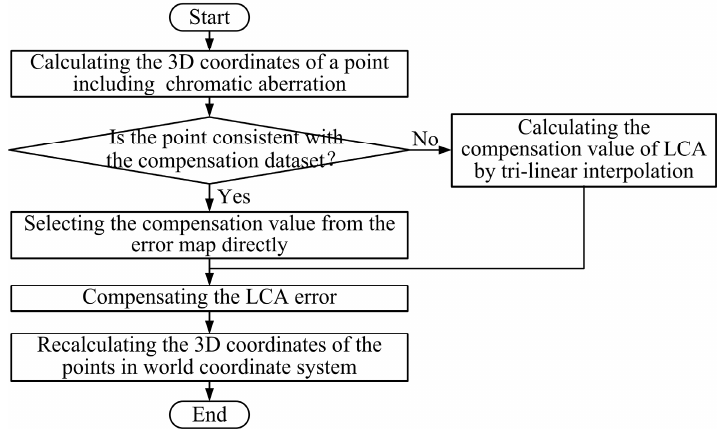
Figure 10. Flow chart of LCA error compensation.